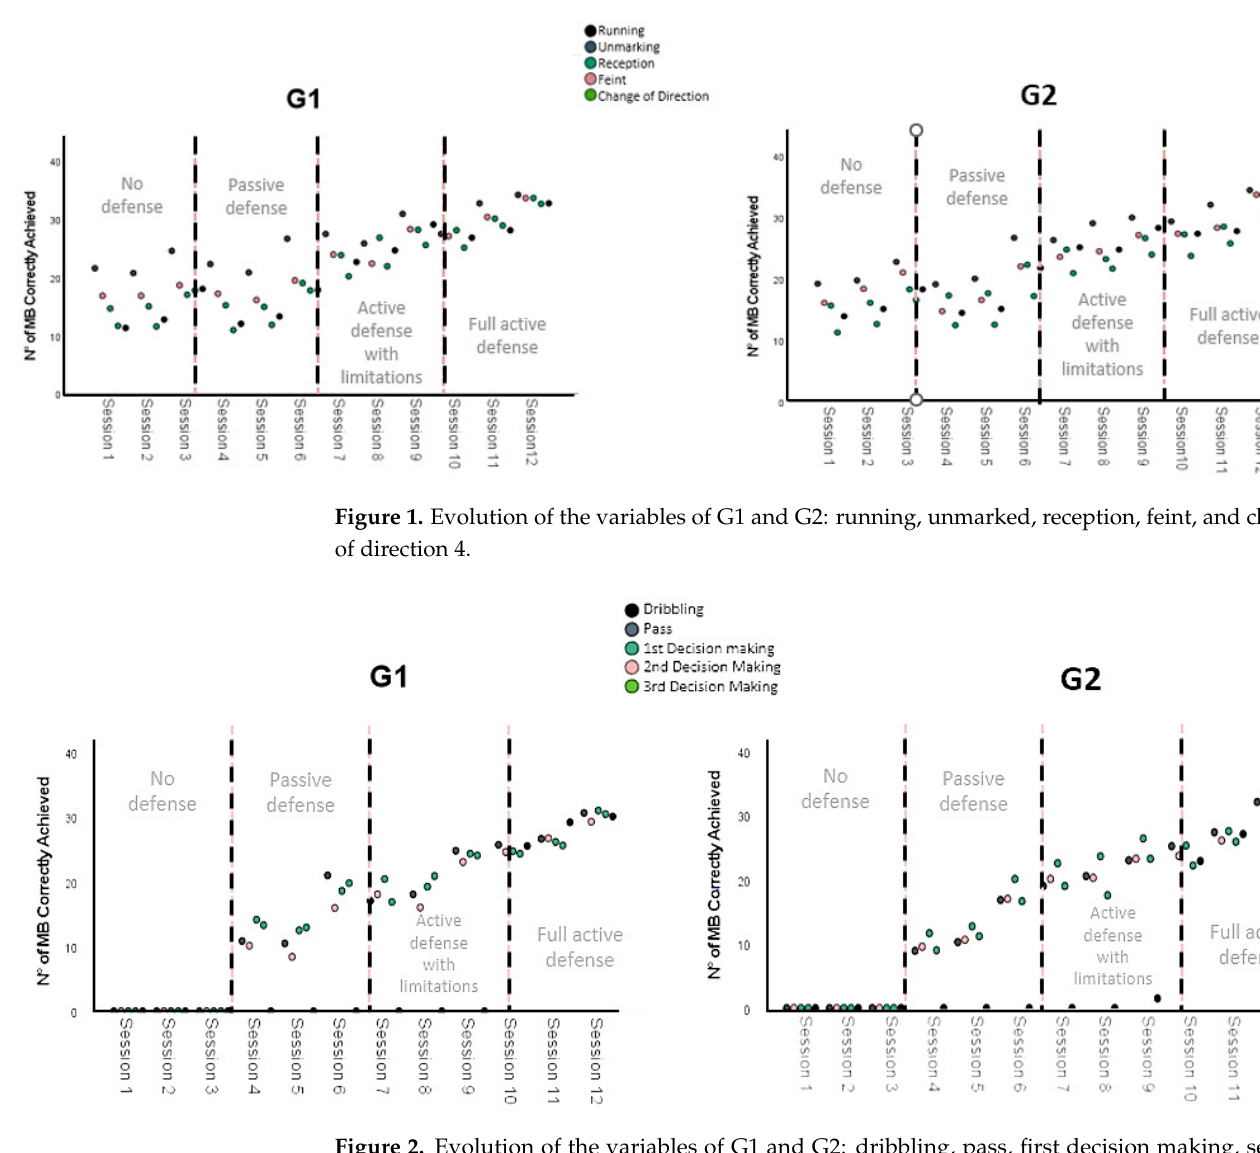
Figure 2. Evolution of the variables of G1 and G2: dribbling, pass, first decision making, second decision making, and third decision making. Table 3. Asymptotic sigma values of the Mann–Whitney U test for comparison between groups G1 and